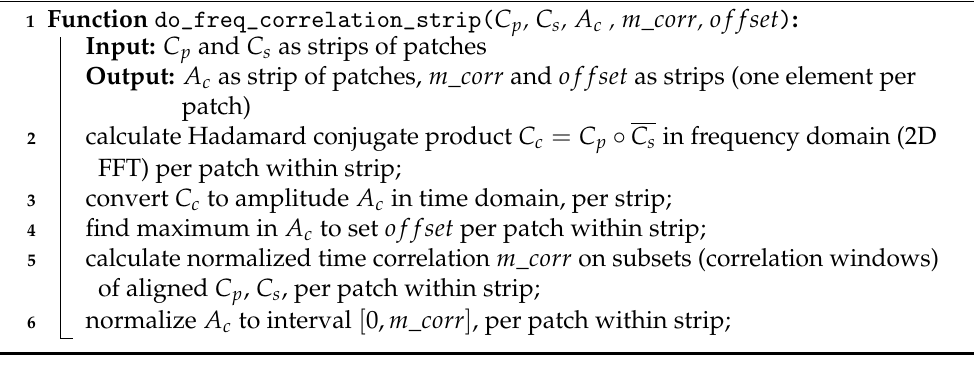
Algorithm 3: GPU-parallel algorithm for frequency cross-correlation.